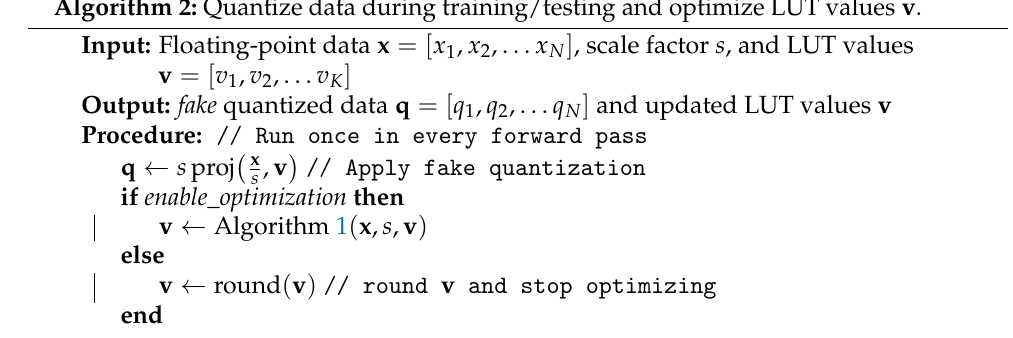
Algorithm 2: Quantize data during training/testing and optimize LUT values v